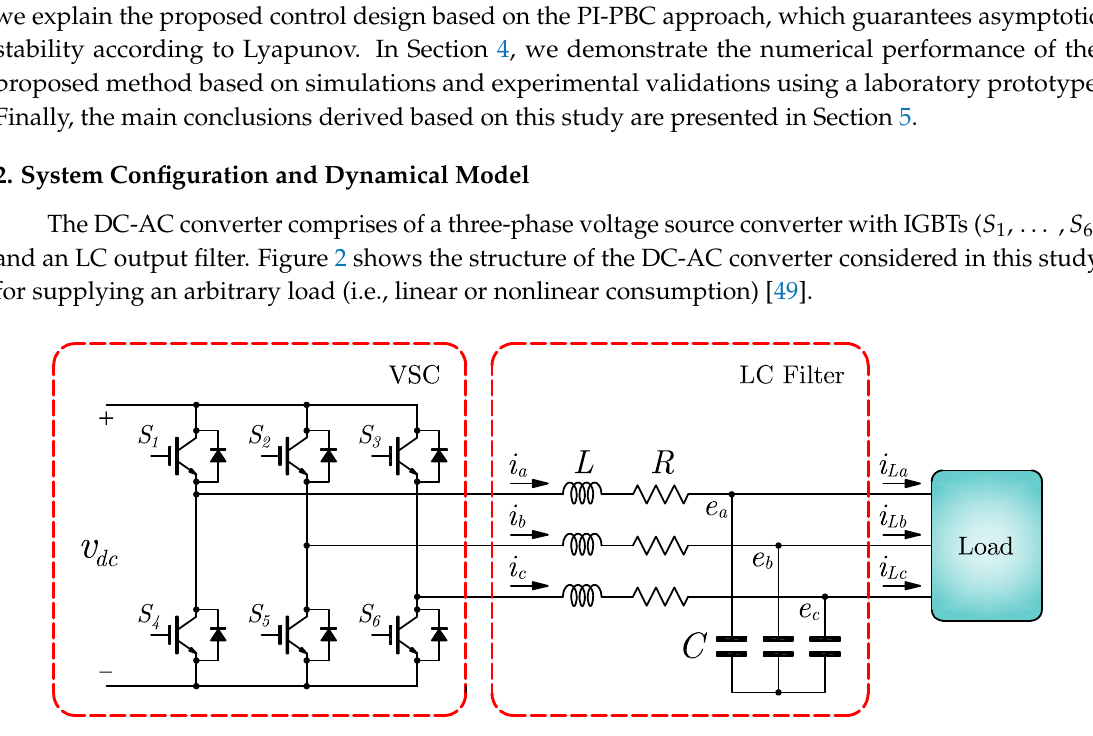
Figure 2. Three-phase DC-AC converter